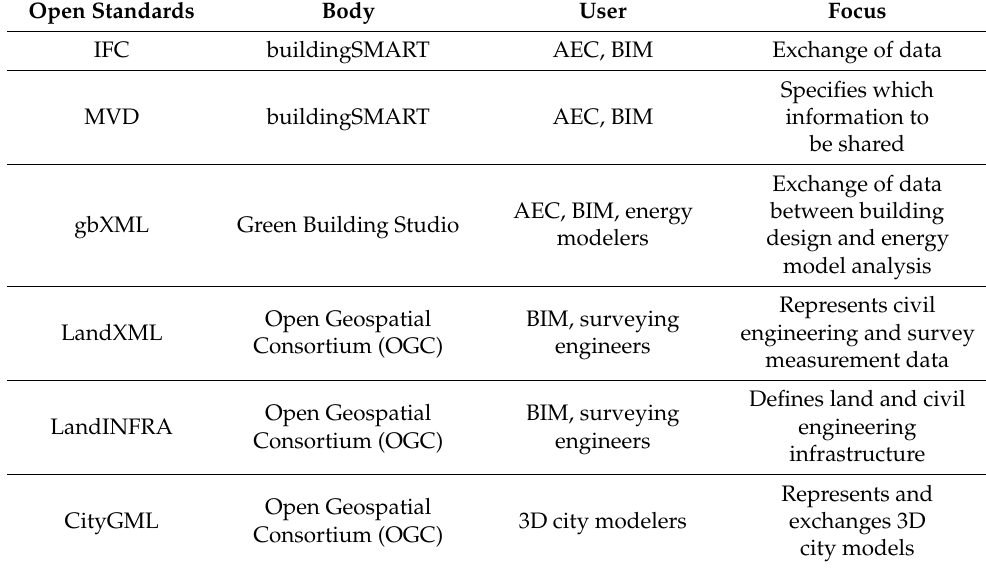
Table 10. Summary of open